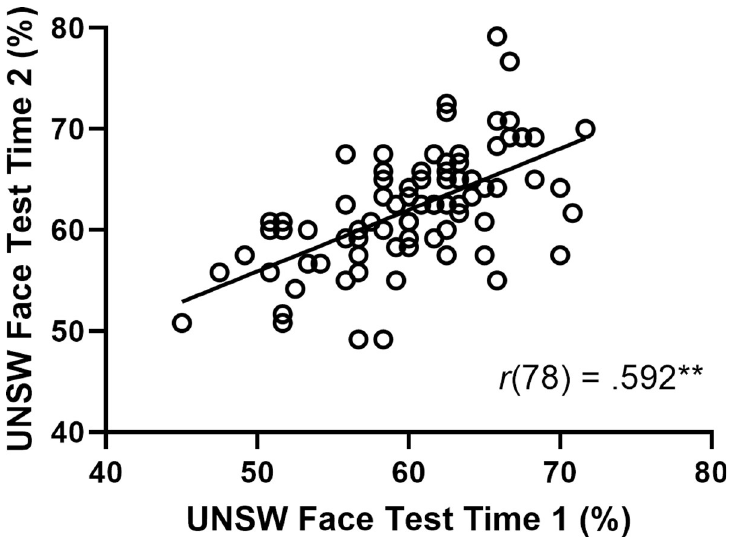
Fig 7. Test-retest reliability on the UNSW face test after a one-week delay. �� Significant at .01 level.